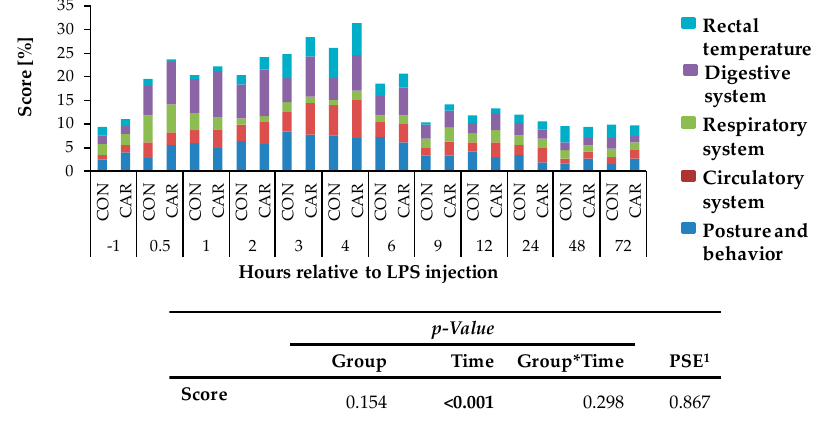
Figure 4. Cumulative clinical score (maximum reachable score: 31 points/100%), consisting of percentages of different categories (posture and behavior, circulatory, respiratory, digestive system and rectal temperature) of cows fed a non-supplemented (CON) or a L-carnitine supplemented diet (CAR, 25 g/d from 6 weeks ap up to day 126 pp) before and after an intravenous injection of 0.5 μ g/kg BW lipopolysaccharides (LPS) on day 111 pp. Data are given as LS-Means. 1 Pooled standard error is listed. Significant p -values are marked as bold.